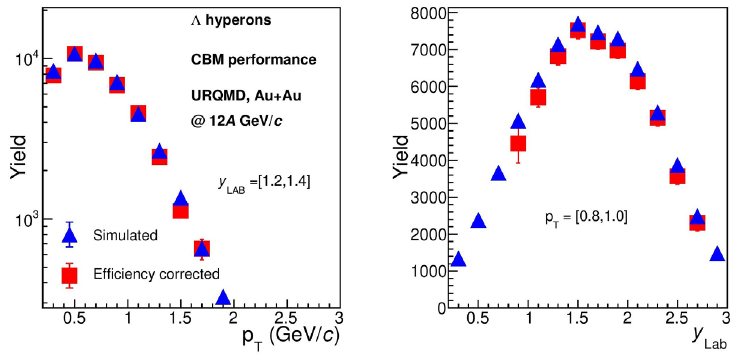
Figure 3. Yield of Λ hyperons as a function of (left) transverse momentum, p T , for rapidity 1 . 2 < y lab < 1 . 4 and (right) rapidity for 0 . 8 < p T < 1 .